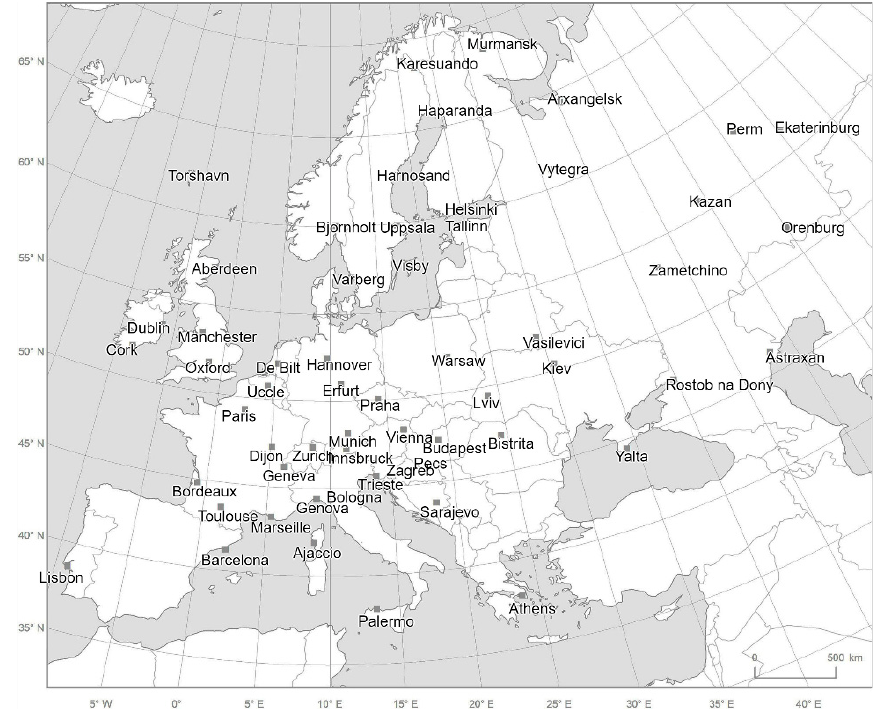
Figure 1. Locations of the meteorological stations used in the study.